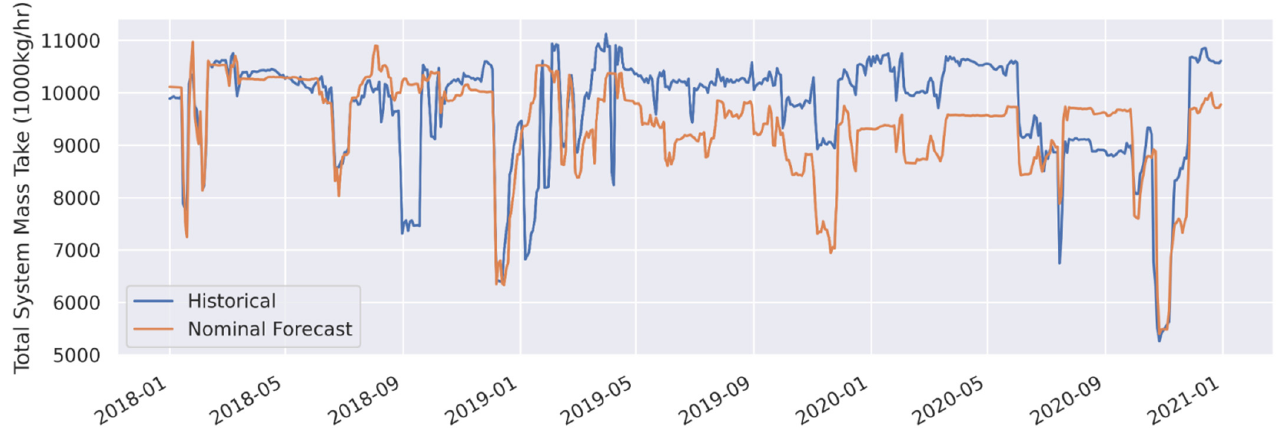
Figure 2. Total system mass take, comparing historically measured data versus the nominal forecast model.